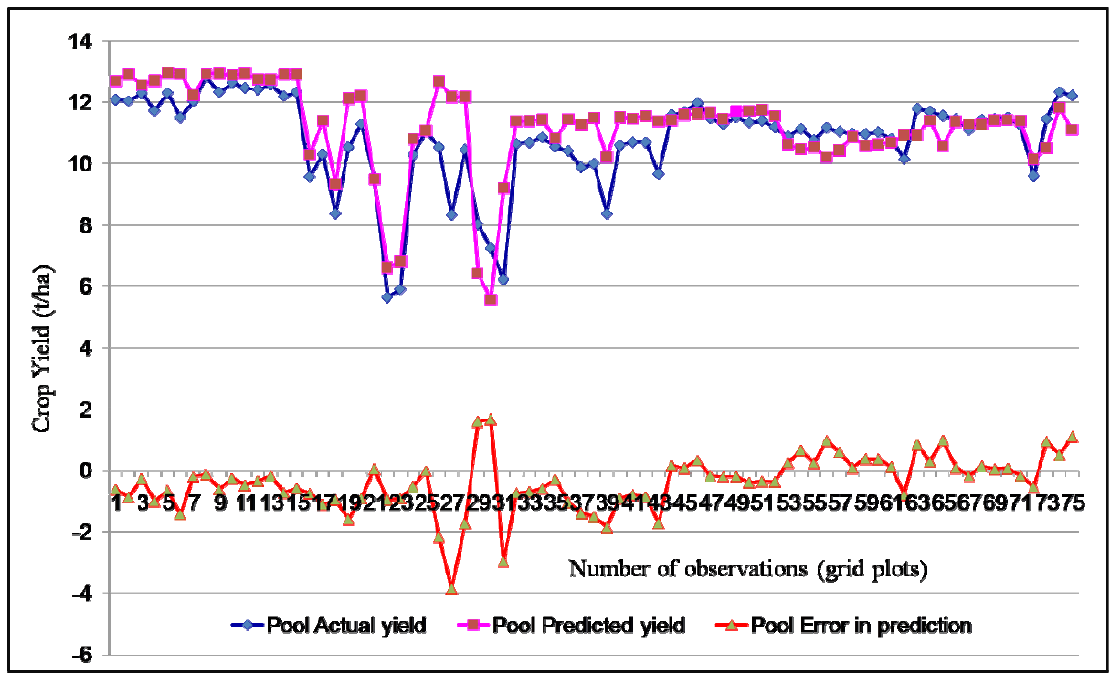
Figure 16 : Comparison of actual versus predicted corn yield using testing dataset selected from all three years (1998, 1999, and 2001) pool data (Transformed PVI